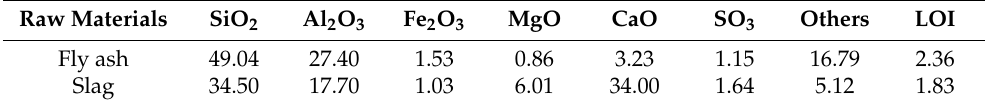
Table 1. Chemical composition of raw materials (wt%). Raw